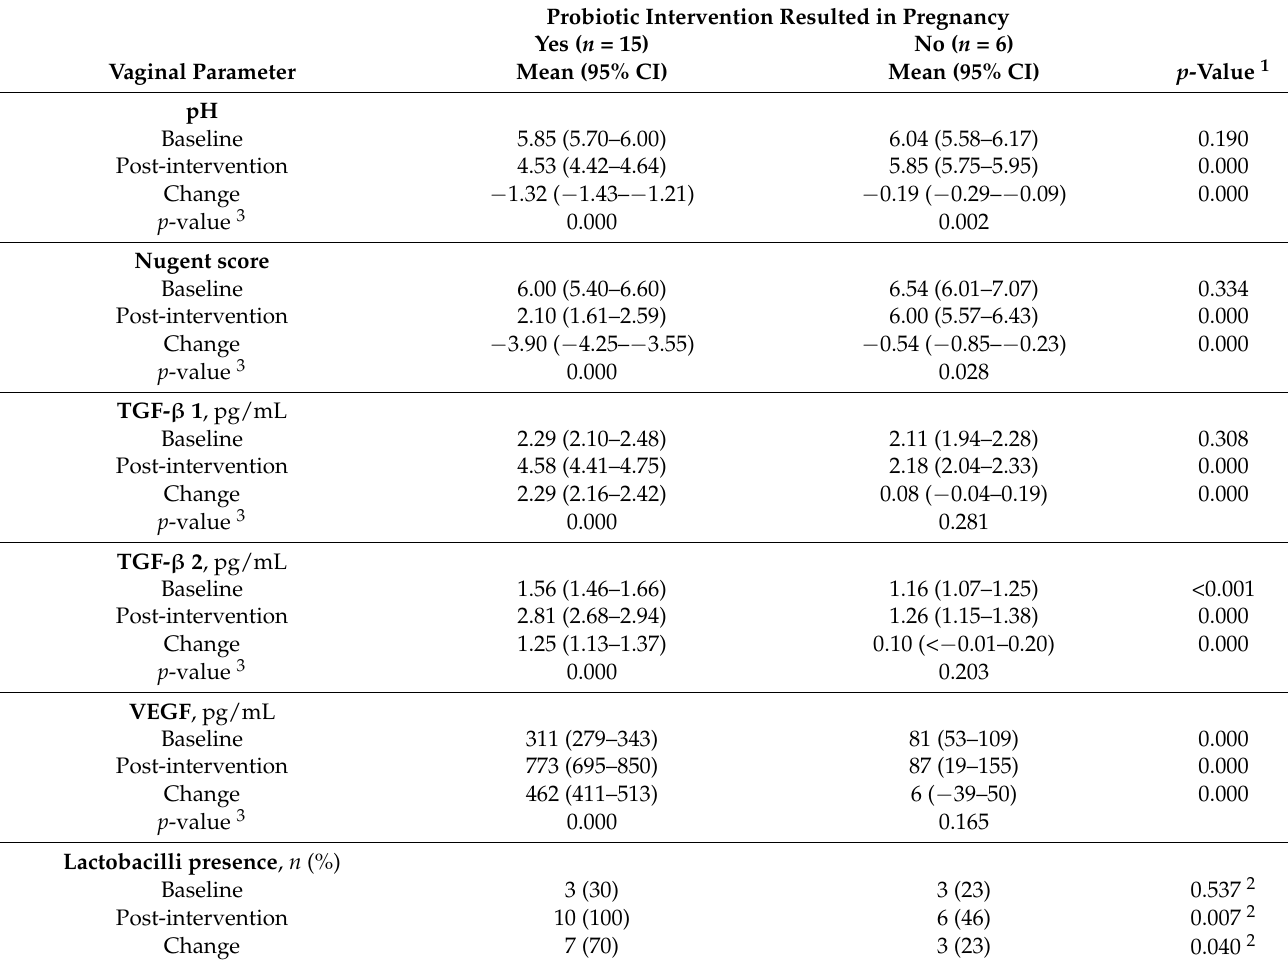
Table 6. Effect of the probiotic intervention with L. salivarius CECT5713 on the vaginal parameters of women who were able to complete a full-term pregnancy ( n = 15) and of those who did not ( n = 6) among the women with infertility of unknown origin (INF group; n =